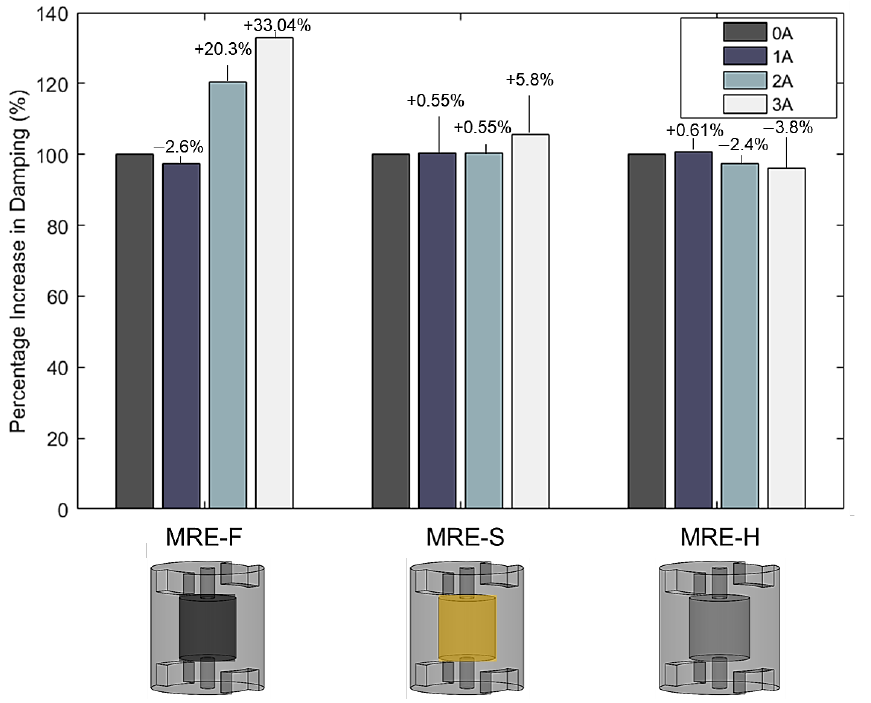
Figure 16. The percentage increase in the damping coefficient for MRE-F, MRE-S, and MRE-H. MRE-F recorded the highest percentage increase in the damping with a value of Table 5. The damping coefficients of MRE-F, MRE-S, and MRE-H at different current values.